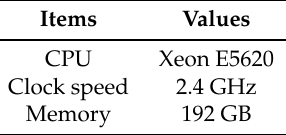
Table 3. Hardware configuration for simulation.